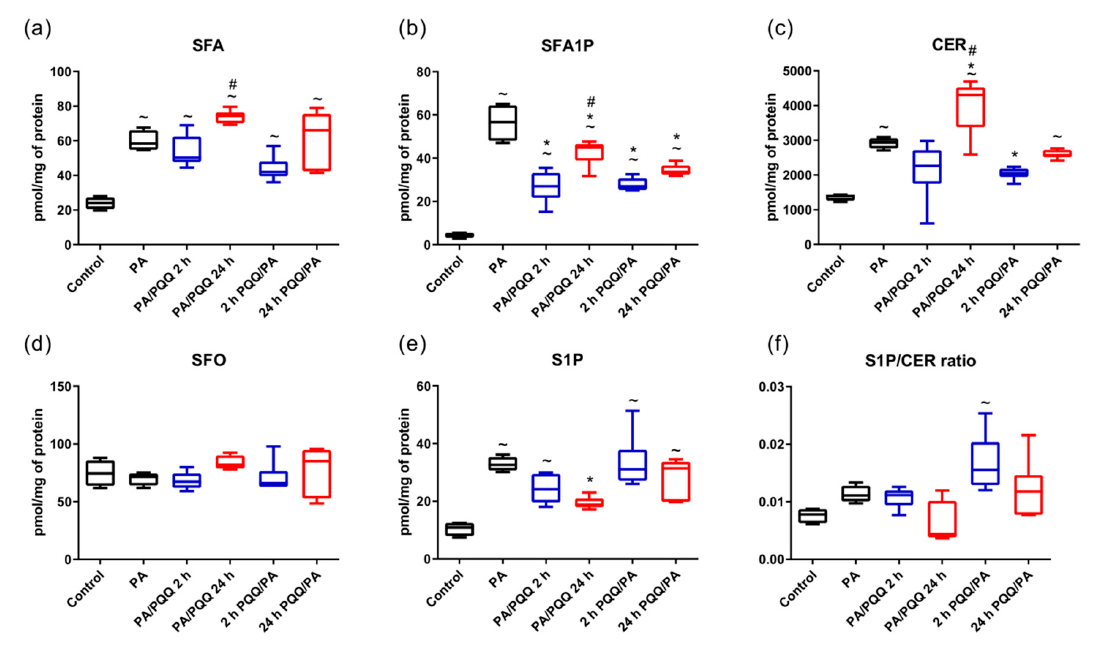
Figure2. Effectsofshort-andlong-timeincubationwithPQQontheintracellularcontentof( a )sphinganine, Figure 2. Effects of short- and long-time incubation with PQQ on the intracellular content of ( a ) ( b ) sphinganine-1-phosphate, ( c ) ceramide, ( d ) sphingosine, ( e ) sphingosine-1-phosphate, and ( f ) S1P / sphinganine, ( b ) sphinganine-1-phosphate, ( c ) ceramide, ( d ) sphingosine, ( e ) ceramides (CER) ratio. The results are based on six independent determinations. ANOVA with a post sphingosine-1-phosphate, and ( f ) S1P/ceramides (CER) ratio. The results are based on six hoc Tukey’s test or the Kruskal–Wallis test followed by post hoc adjustment were applied. For the independent determinations. ANOVA with a post hoc Tukey’s test or the Kruskal–Wallis test consistency of data presentation median (min–max) values were used. ~ p < 0.05, study groups versus control; * p < 0.05, PQQ-incubated groups versus palmitate group; # p < 0.05, time-dependent di ff erences (long- vs. short-time incubation with PQQ). PA: palmitic acid; PQQ: pyrroloquinoline